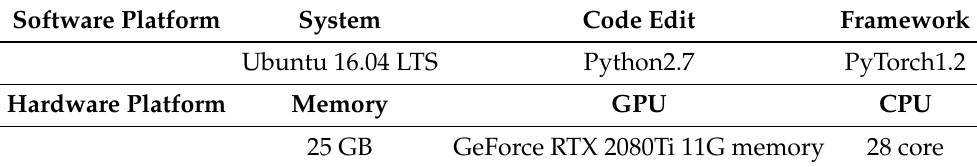
Table 1. Computer